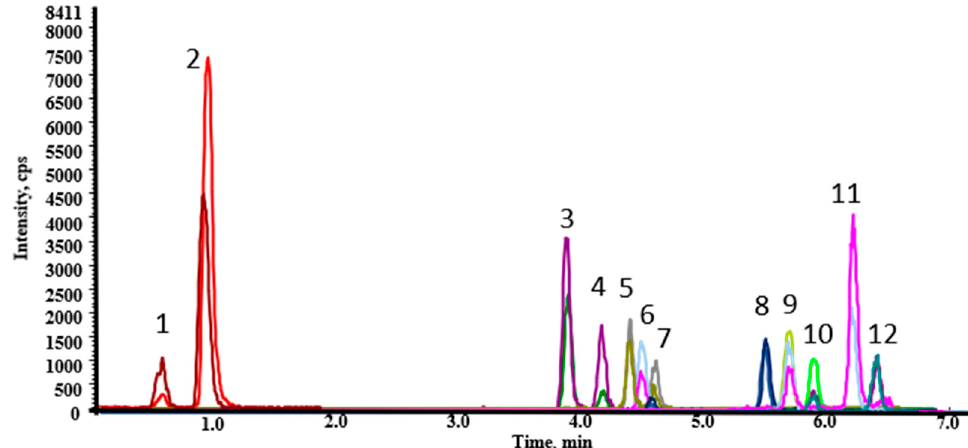
Figure 3. UHPLC-ESI (+)-MS/MS extracted ion chromatogram of a blank oat sample spiked with EAs at 10 µ g/kg: (1) Em, (2) Emn, (3) Esn, (4) Es, (5) Etn, (6) Eco, (7) Et, (8) Econ, (9) Ekr, (10) Ecr, (11) Ekrn, (12) Ecrn.